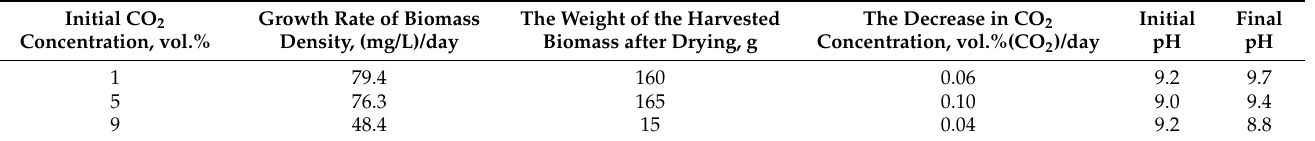
Table 1. Summary of the